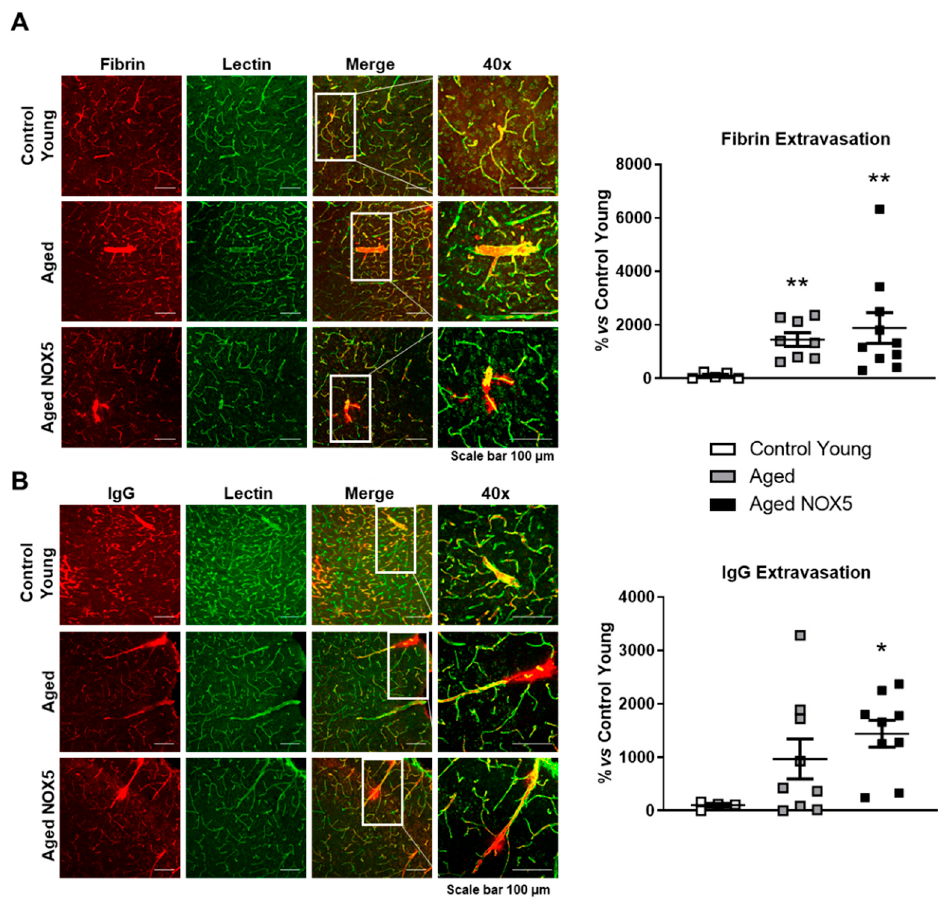
Figure 6. BBB leakage determination by IF assays. A representative confocal microscopy analysis of ( A ) fibrin (red) or ( B ) immunoglobulin G (red) and lectin-positive capillaries (green) on cortical brain sections. * p < 0.05 and ** p < 0.01 vs. Control Young . Scale bar, 100 µ m. n = 6–10. The results are expressed as the mean ± SEM. Kruskal–Wallis test. Control Young : young mice, Aged : CRE +/ − aging mice and Aged NOX5 : NOX5 +/ − CRE +/ − aging mice.